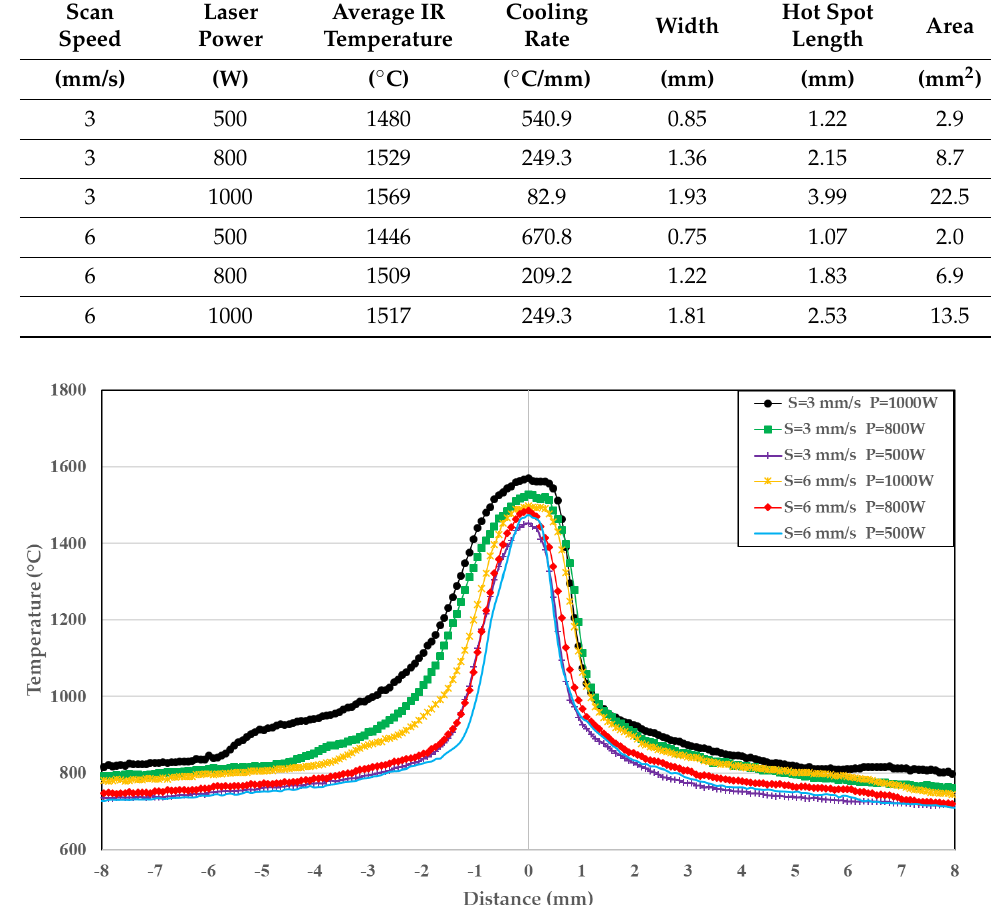
Figure 9. Temperature profile of laser hot spots plotted along the dashed lines from Figure 8. During laser cladding, the temperature seemed to fluctuate, and the shape of the molten pool was more reliable for process condition monitoring. Therefore, using Lab- VIEW software, the hot spot’s width, length, and area can be extracted in real time for analysis. Table 3 shows the infrared temperature, thermal gradient, length, width, and area of the hot spots. The length of the hot spot (along the scan direction) depended more on the laser scanning speed than the laser power. The cooling rate was calculated by using the slope of the left temperature gradient curve at around 1000 °C. Table 3. Extracted data from infrared images of the cladding hot spot.